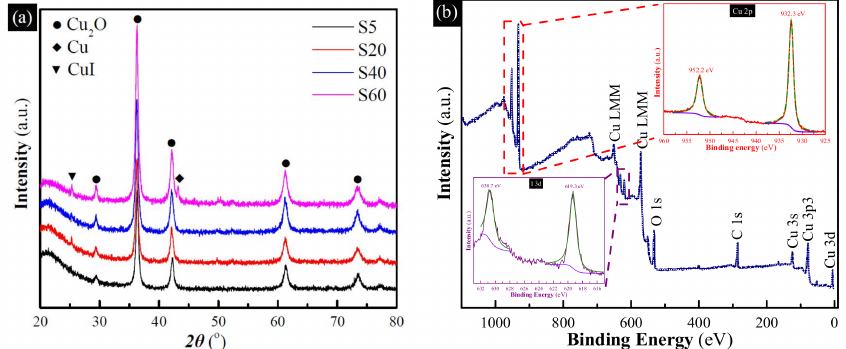
Figure 5. ( a ) XRD patterns of hollow Cu-based adsorbents after the uptake of I − anions; ( b ) XPS patterns of S40 after the uptake of I − anions, inset are the high-resolution spectra of Cu 2p and I 3d peaks, respectively.